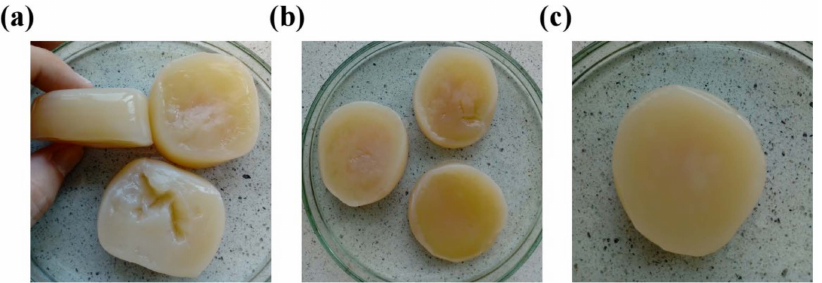
Figure 7. Bacterial cellulose membranes produced by chosen bacterial strains: ( a ) K. hansenii H3 (6Et), ( b ) K. rhaeticus K4 (8Et), and ( c ) Komagataeibacter sp. isolated from balsamic vinegar